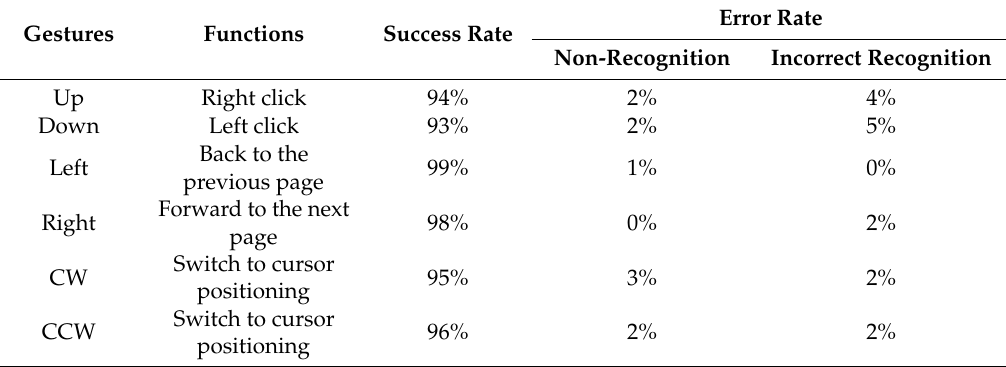
Table 7. Result of the web surfing experiment (participant = 5; trials = 50).